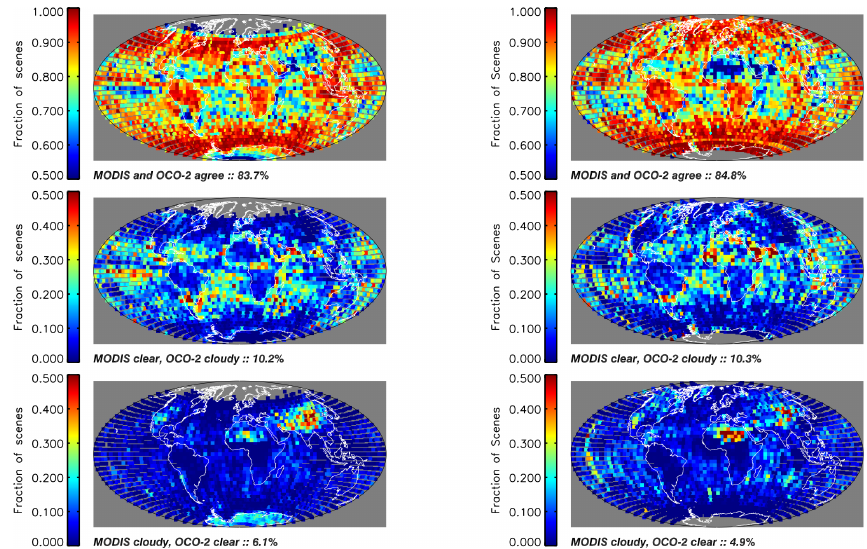
Figure 6. Combined glint and nadir gridded contingency table data for December (left column) and April–May (right column). Data are binned on a 4 ◦ by 4 ◦ lat/long grid. Scenes for which MODIS and OCO-2 cloud screenings agree are shown in the top panel, while the two types of disagreement – MODIS clear, OCO-2 cloudy and vice versa – are shown in the two lower rows, respectively. The color scales span the range 50–100% for the “agree” panels and 0–50% for the “disagree” panels.